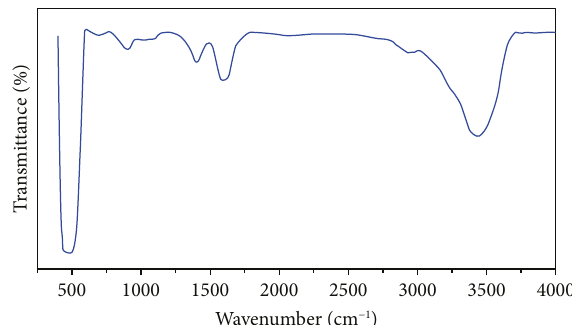
Figure 7: FTIR spectrum of the zinc oxide